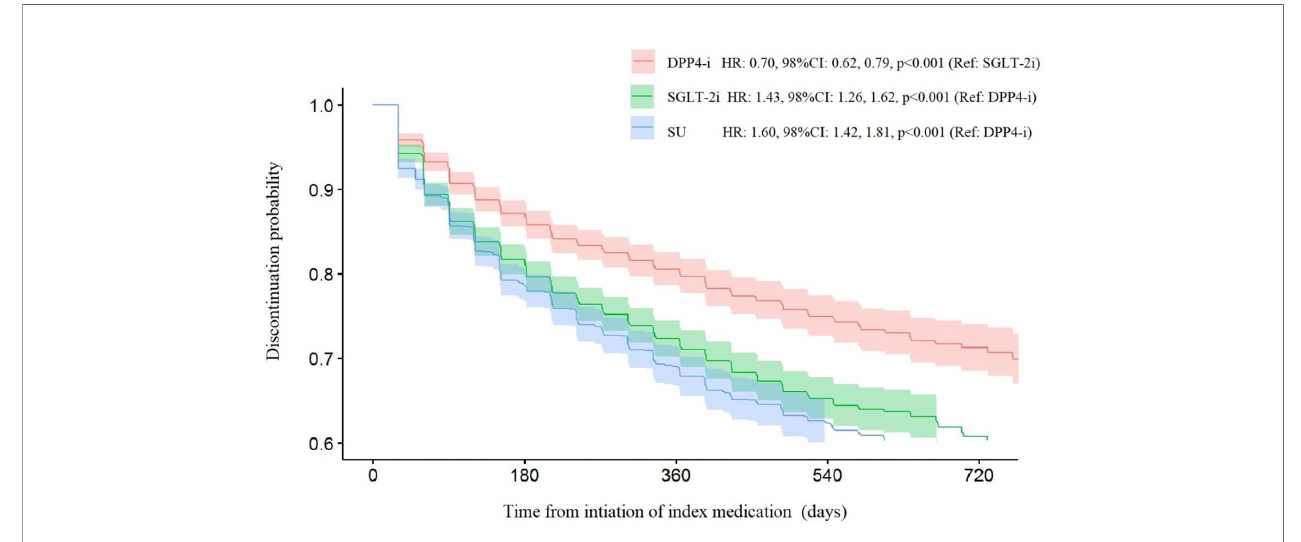
FIGURE 1 | Kaplan-Meier discontinuation probability curves for the three treatment groups.